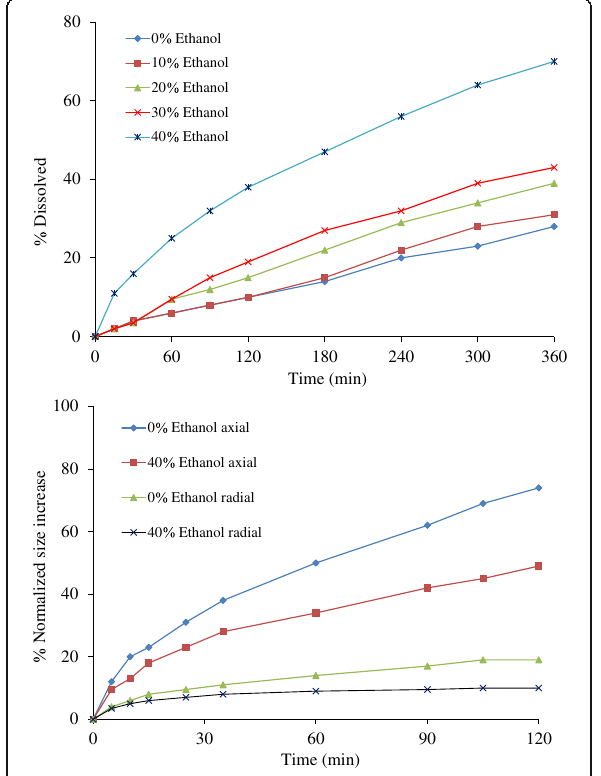
Fig. 25 Effect of ethanol on release of aspirin (data from reference (Roberts et al. 2007))